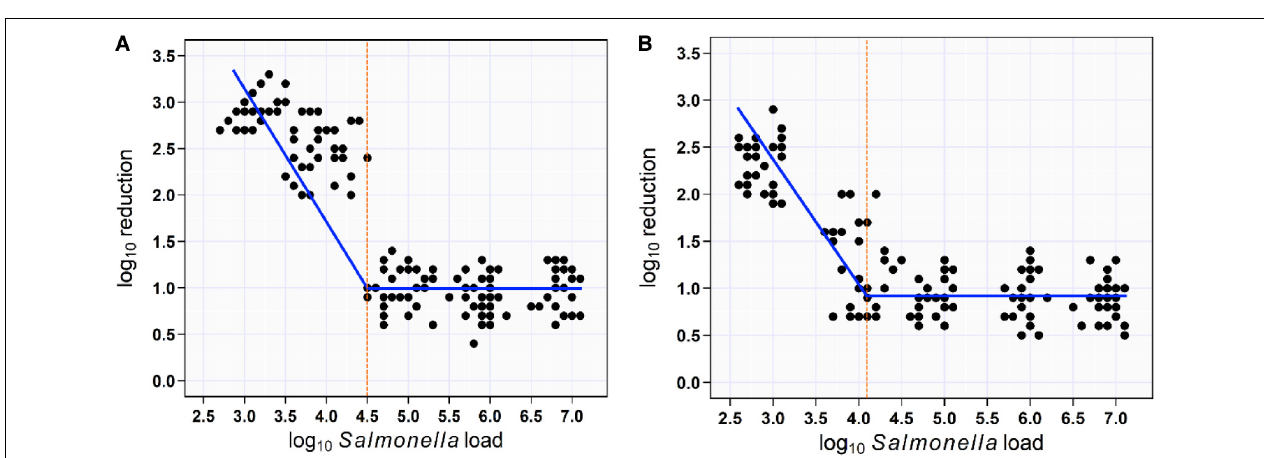
FIGURE 5 | Scatterplot of the relationship between aSTC load and reduction rate. Segmented mixed models regression fitted two lines to the aSTC load–reduction rate relationship and identified a break point (aSTC load = 4.5-log 10 ) where the reduction rate increased markedly using multi-sequential soaking approach (A) . Segmented mixed models regression fitted two lines to the aSTC load–reduction rate relationship and identified a break point (aSTC load = 4.2-log 10 ) where the reduction rate increased markedly using multi-sequential spraying approach (B)